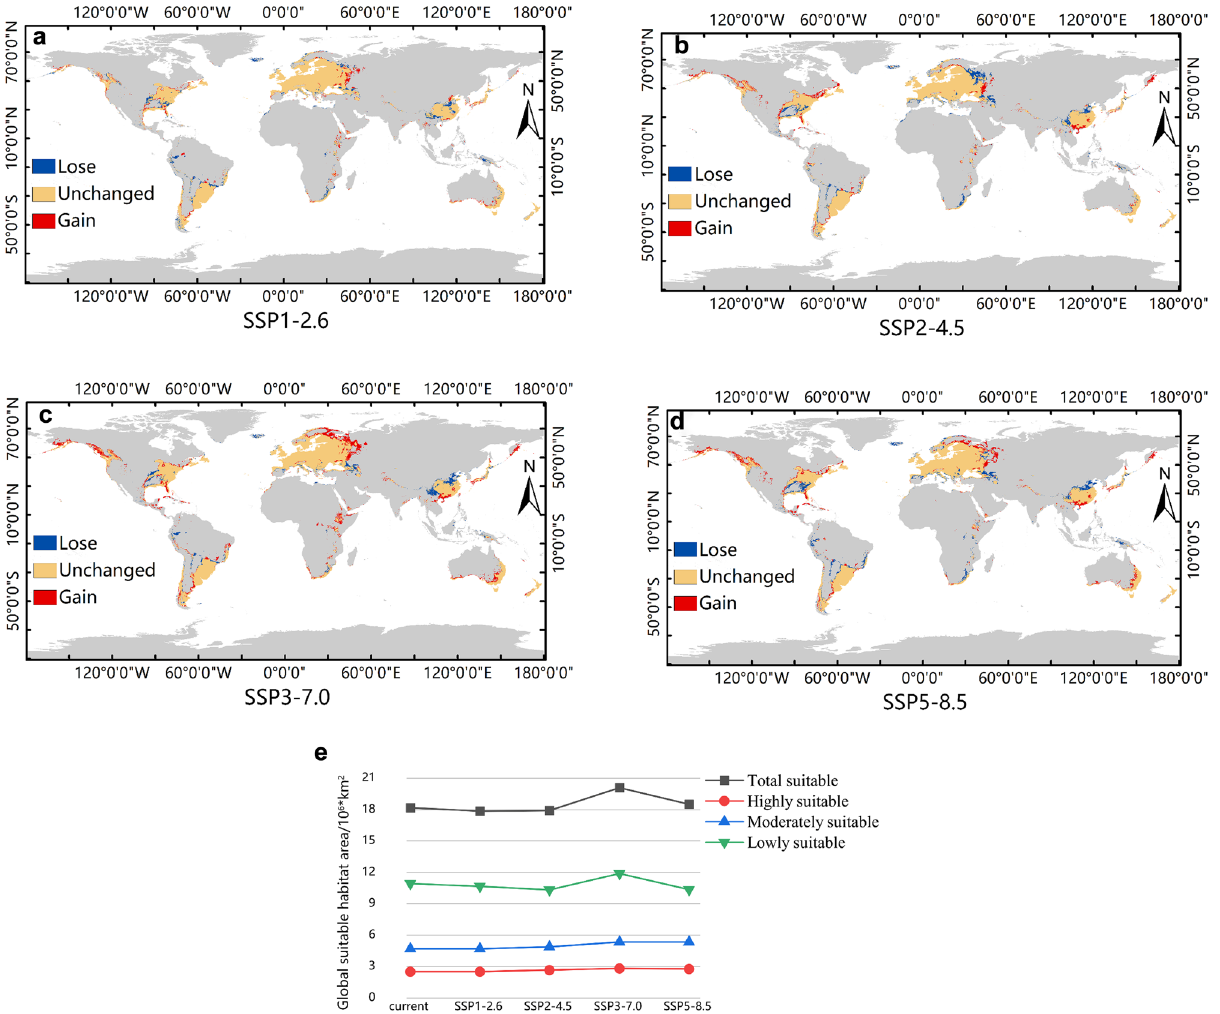
Figure 6. Changes of the global suitable habitats of N. alata between different future climate scenarios and the current climate conditions. ( a ) the global suitable habitats changes of N. alata between the future SSP1-2.6 climate scenario and the current climate conditions, ( b ) the global suitable habitats changes of N. alata between the future SSP2-4.5 climate scenario and the current climate conditions, ( c ) the global suitable habitats changes of N. alata between the future SSP3-7.0 climate scenario and the current climate conditions, ( d ) the global suitable habitats changes of N. alata between the future SSP5-8.5 climate scenario and the current climate conditions, ( e ) area line chart of suitable habitats of N. alata under current climate condition and four future climate scenarios. This base map was directly obtained from the calculation of MaxEnt with the bioclimatic data from WorldClim. Global bioclimate data were acquired from the WorldClim open database (https:// world clim. org). The locations of species occurrence were collected from open databases: GBIF (http:// www. gbif. org), the Chinese Virtual Herbarium (CVH, https:// www. cvh. ac. cn/), the National Specimen Information Infrastructure (NSII, http:// nsii. org. cn/ 2017/ About Us. php), and Chinese Field Herbarium (CFH, https:// cfh. ac. cn/). The species distribution model was conducted with MaxEnt (Version 3.4.4, http:// biodi versi tyinf ormat ics. amnh. org/ open_ source/ maxent/), and results were modified with ArcGIS (version 10.7, https:// www. arcgis.